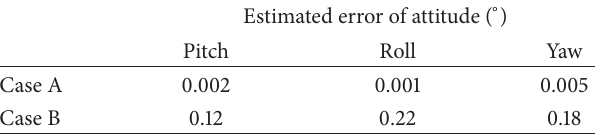
Table 1: Alignment accuracy